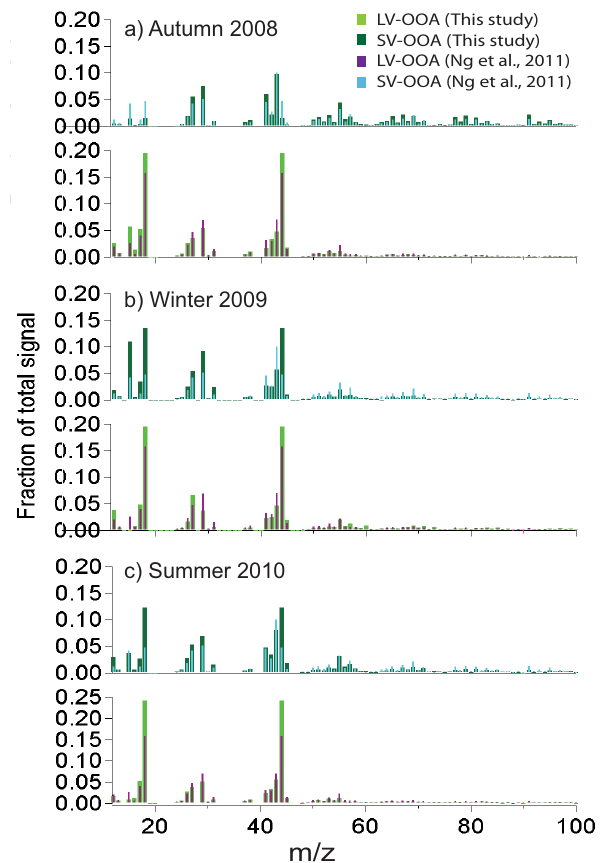
Fig. 3. Average mass spectra of organic species extracted from the total organic mass spectra for the (a) autumn, (b) winter, and (c) summer campaign. Smaller sticks overlayed on each mass spectral pattern represent those of Ng et al. (2011).